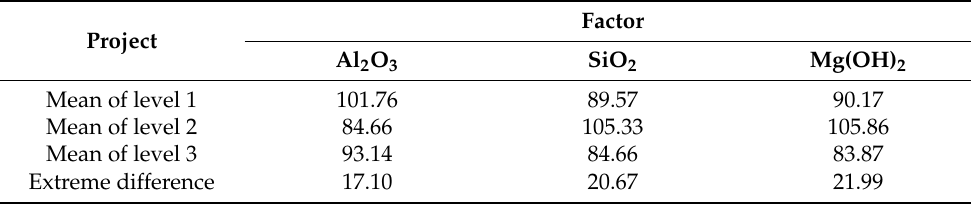
Table 4. Mean and extreme difference analysis of elongation at break for each factor